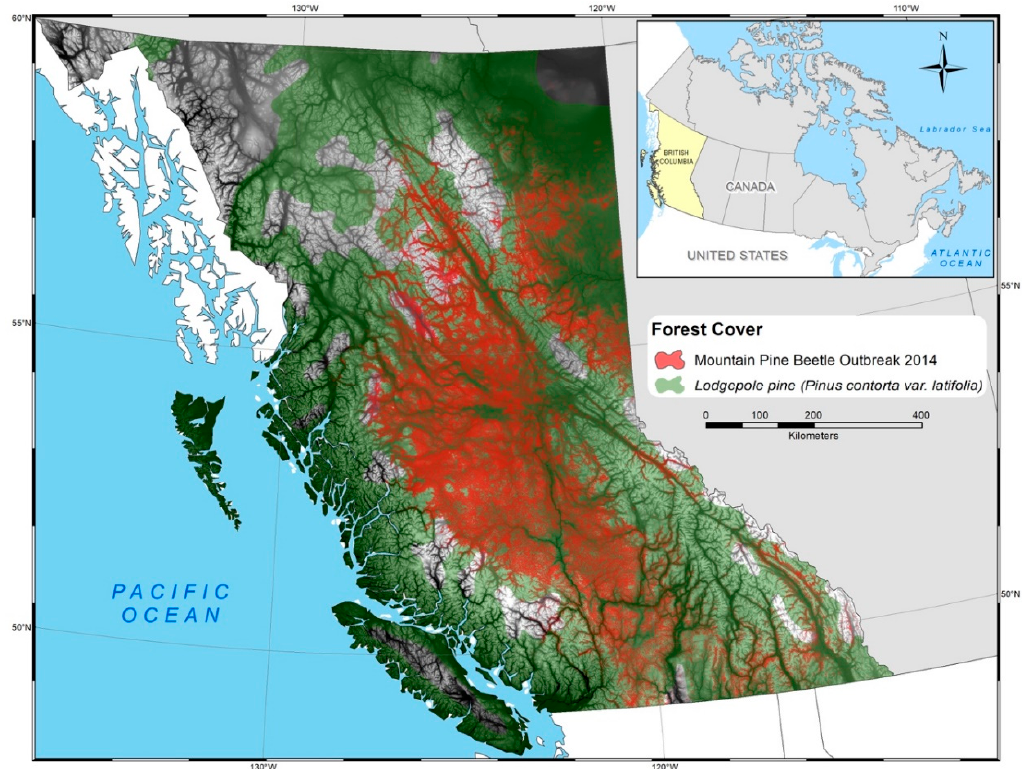
Figure 1. The Province of British Columbia in Canada is mainly dominated by a Lodgepole pine ( Pinus contorta ) forest, which by 2014 had been decimated by almost 50% due to mountain pine beetle (MPB) infestation.